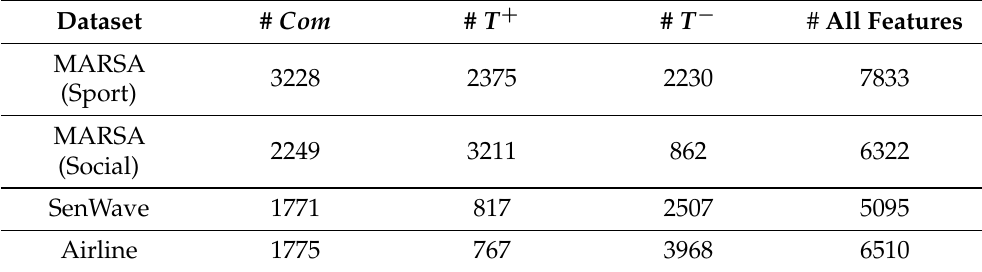
Table 8. Number of unique features (including common and pure features) for each